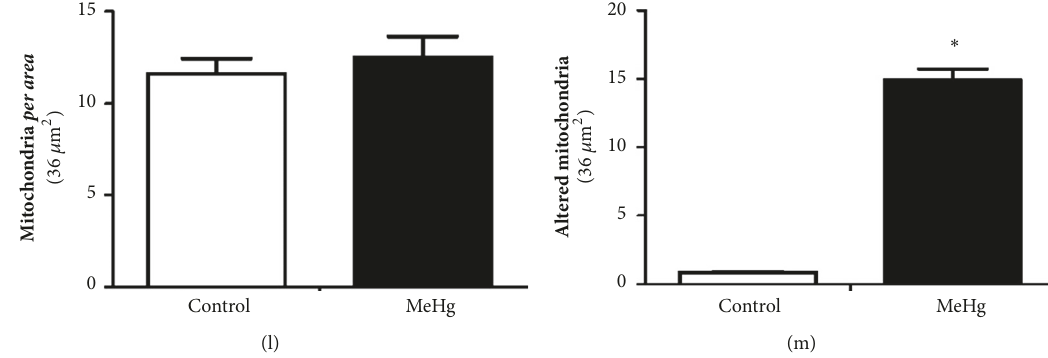
Figure 2: Effects of MeHg on mitochondrial structure in spinal cord of E10 embryos . Electron micrograph showing mitochondria in the mantle layer of control and MeHg-treated embryos. Mitochondria (M) in control embryos showed mitochondrial crests (C), internal mitochondrial membrane (IMM, white arrow), and external mitochondrial membrane (EMM, black arrow) visualized in longitudinal (a, c) and transverse planes (a, d). Mitochondria of the MeHg-treated embryos showed ruptures in the EMM (black arrowhead), loss and disorganization of crests, swelling ( ∗ ) in the mitochondrial matrix, and vacuolization ( ∗∗ ) between IMM and EMM. Unusual mitochondrial shapes, cup-like (i) and donut-like (j-k), were observed in MeHg-treated embryos. Fusion (white arrowhead) in mitochondrial donut-like shape. The graphs show the total number of mitochondria (l) and the number of altered mitochondria (m) in control and MeHg-treated groups. ∗ indicates P < 0.05. Nucleus (N), endoplasmic reticulum (ER), and Golgi complex (GC). Scale bars: (a-b) 1 𝜇 m; (c–k) 200